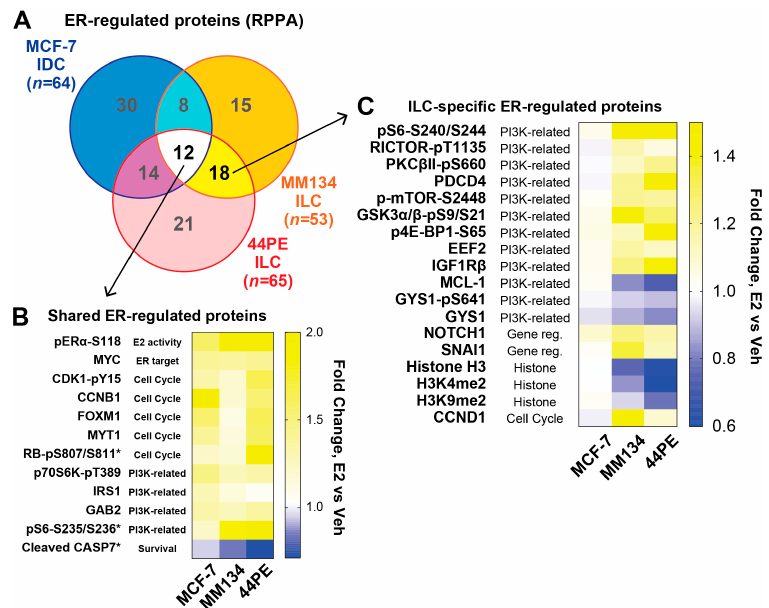
Figure 1. Estrogen regulates distinct protein targets in invasive lobular carcinoma (ILC) cells vs. MCF-7 invasive ductal carcinoma (IDC) cells. Reverse phase protein array (RPPA) was used to identify signaling changes after treatment with estrogen, comparing ILC models MDA MB 134VI (MM134) and SUM44PE (44PE) to IDC model MCF-7. Cells were hormone-deprived prior to treatment with 100pM estradiol (E2) for 24 h (biological triplicate). ( A ), RPPA targets with significant changes for E2 vs. vehicle (-E2) samples were compared per cell line (q < 0.05 for MM134 and 44PE; q < 0.25 for MCF-7; see text). (B–C), Heatmaps for fold change, E2 vs. veh (mean of biological triplicate). Gene ontology derived from DAVID database. ( B ), Shared/common E2-regulated targets in all three cell lines. * MCF-7 E2 vs. veh q > 0.05. ( C ), E2-regulated targets identified in both ILC models but not in MCF-7 cells.